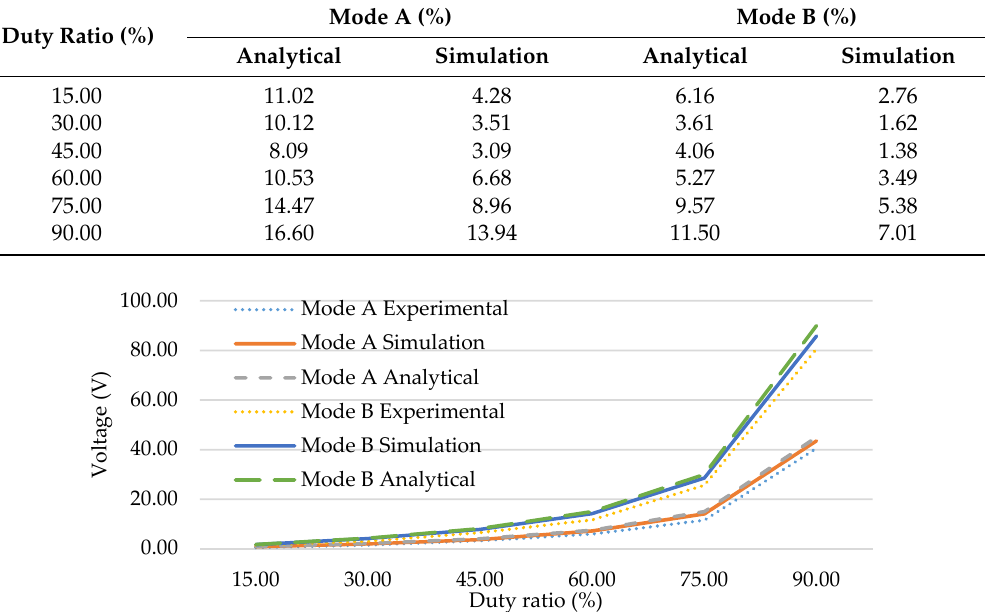
Table 5. Percentage deviation of the output voltage of the converter measured experimentally from the results obtained in the simulation and analytical calculations.